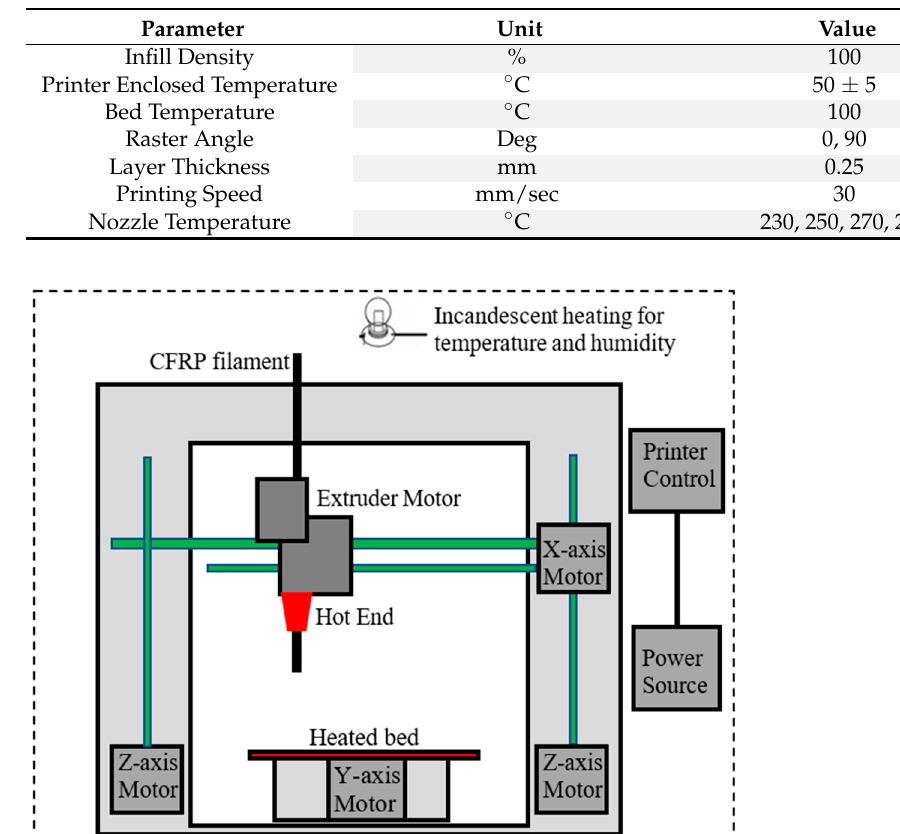
Figure 1. Setup of a 3D printer to control immediate printing environment temperature and humidity. Based on Adeniran et al. [20].